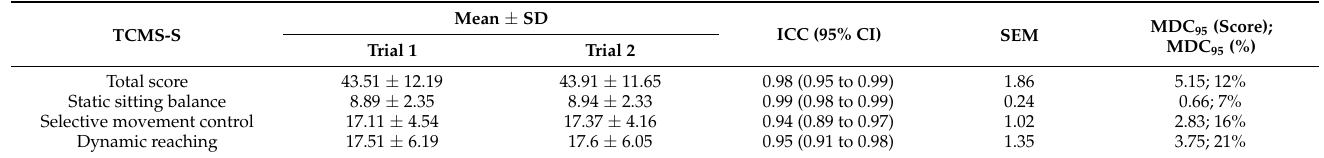
Table 4. Test–retest reliability of the Spanish version of the Trunk Control Measurement Scale total and subscales.